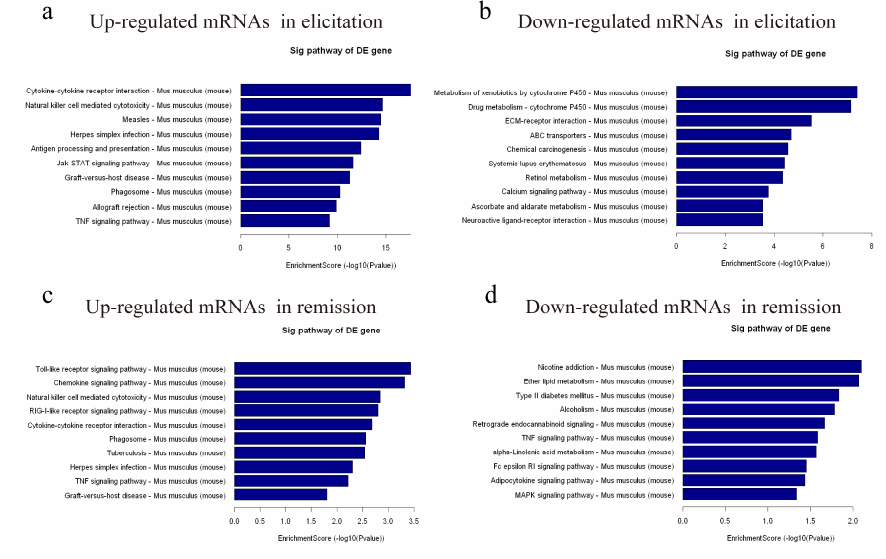
Figure 4. KEGG pathway analysis. ( a – d ) KEGG pathway enrichment analysis of upregulated and downregulated mRNAs in the elicitation and remission phase of the AD recurrence model with the top ten enrichment scores.